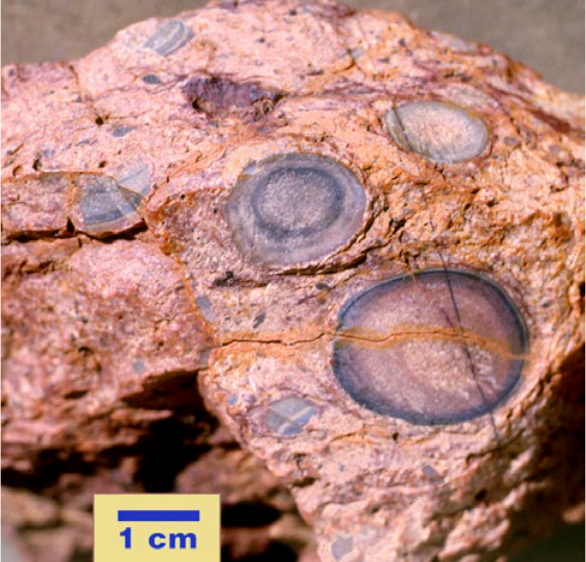
Figure 4. Chert ovoids in the Black Angel porphyroid have concen- tric internal diffusion (Leisegang) banding.